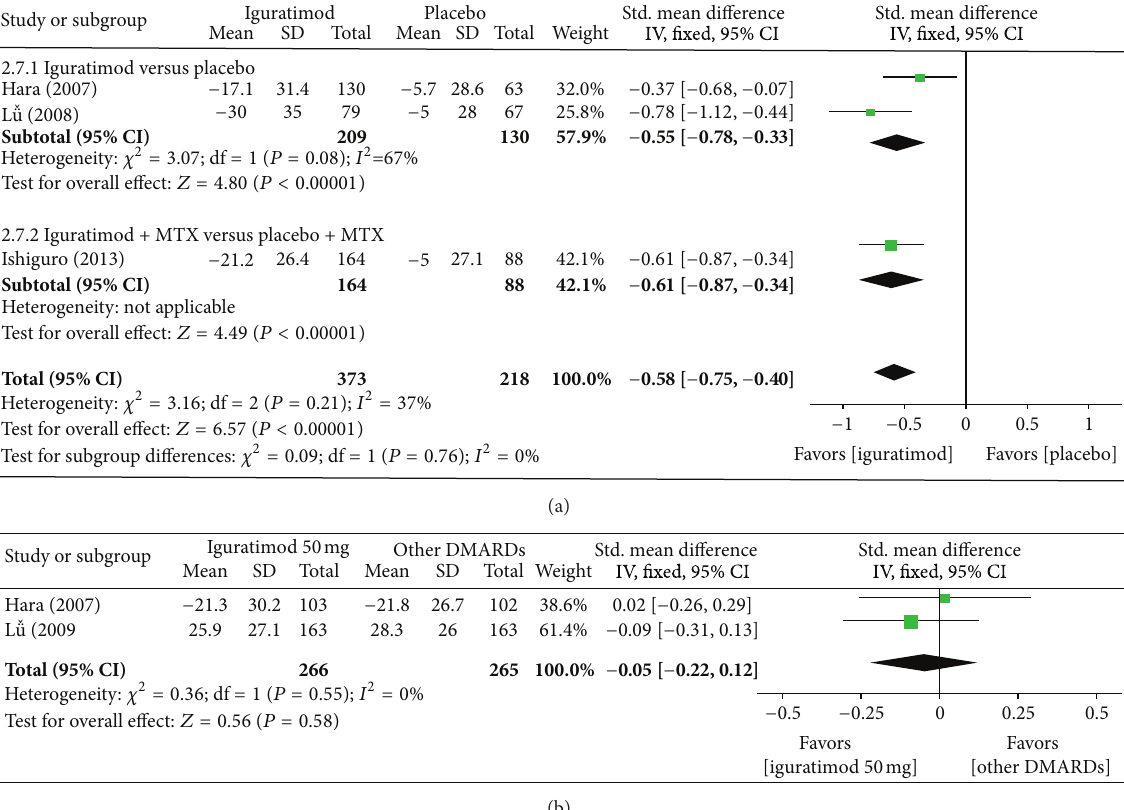
Figure 9: (a) Comparison of patient global assessment of disease activity between iguratimod and placebo groups. (b) Comparison of patient global assessment of disease activity between iguratimod and other DMARDs (MTX and SASP)